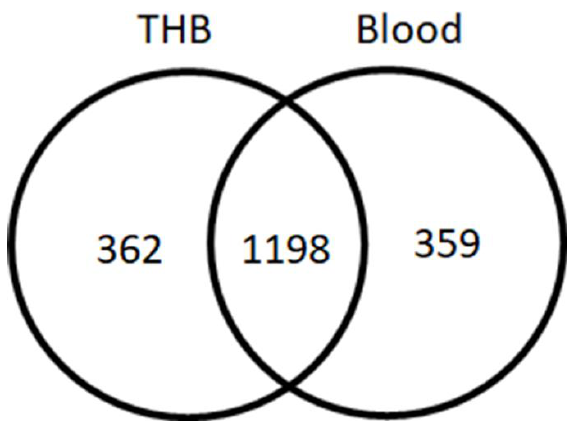
Figure 1. Venn diagram showing the number of proteins in SS2 cultivated in the THB medium with and without whole blood.